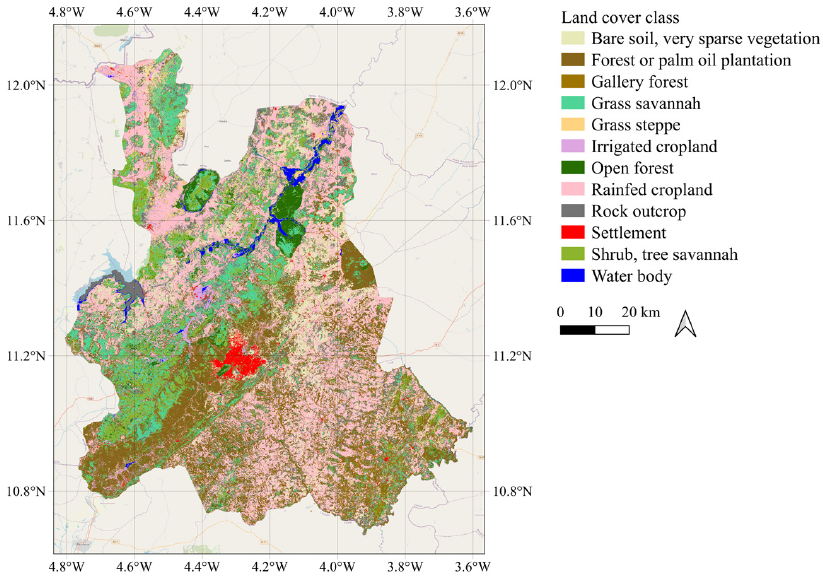
Figure 8. 2020 land-cover map of Houet prepared from the subsets of legends from the Observatory for Sahara and Sahel (OSS) of Burkina Faso (2016).